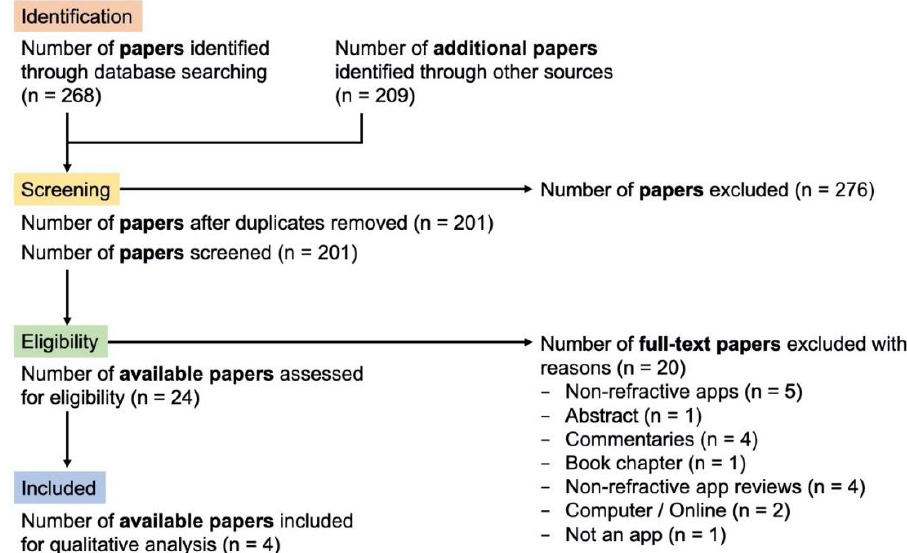
Figure 2. PRISMA flow diagram to highlight the systematic review of the literature using keywords [“toric lens” OR “astigmatism” OR “refraction”] AND [“calculator” OR “mobile application” OR “mHealth”] to search PubMed, Medline and Google Scholar. 477 papers were identified, 201 screened, 24 assessed in full text and 4 studies included.